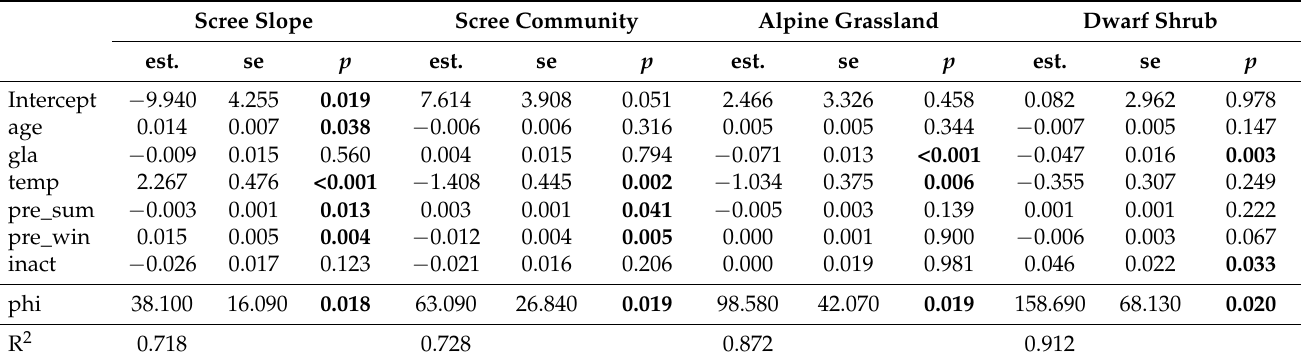
Figure 10. Development of the five years running mean of the mean annual air temperature (red; 2 m above ground) and five years running mean of the sums of the annual precipitation (blue) of the AoI between 1850 and 2020 with corresponding trend lines for the entire epoch (thick line). The 95% confidence interval is included (grey). Table 4. Effects of the years since observation (age), the glacier retreat (gla), the five years running mean temperature (temp), of the five years running mean summer precipitation (pre_sum) and the five years running mean winter precipitation (pre_win), and more stable areas within the AoI (inact) on the main land-cover types. Estimates (est.), standard errors (se), and p -values ( p ) for the independent variables, and phi are shown ( p -values below 0.05 are in